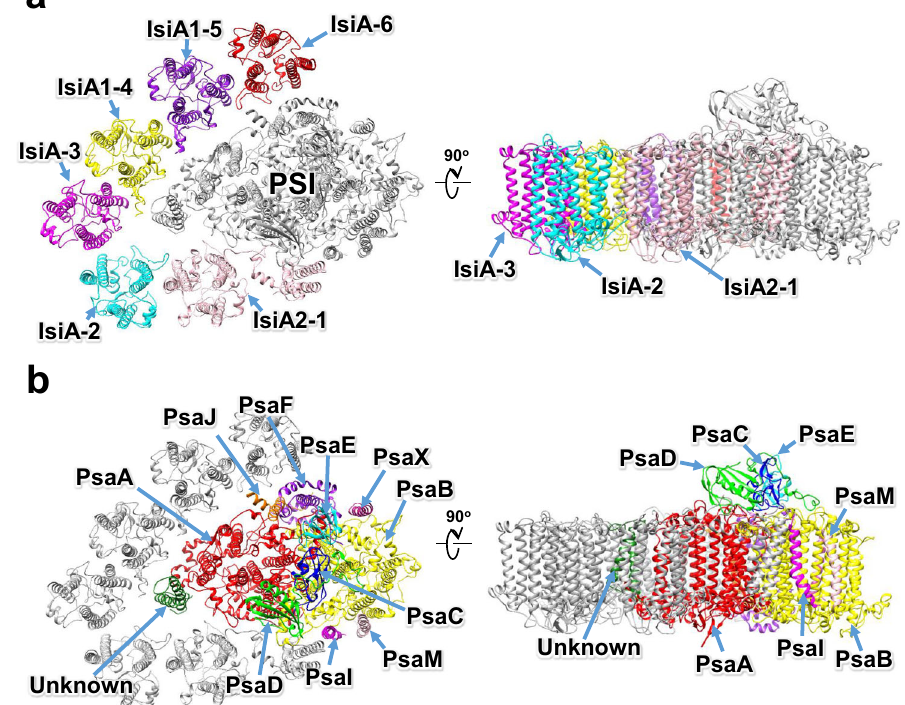
Fig. 1 | Overall structure of the PSI-IsiA supercomplex from Anabaena . Struc- tures are viewed from the cytosolic side (left panels) and the direction perpendi- cular to the membrane normal (right panels). Only protein structures are shown,